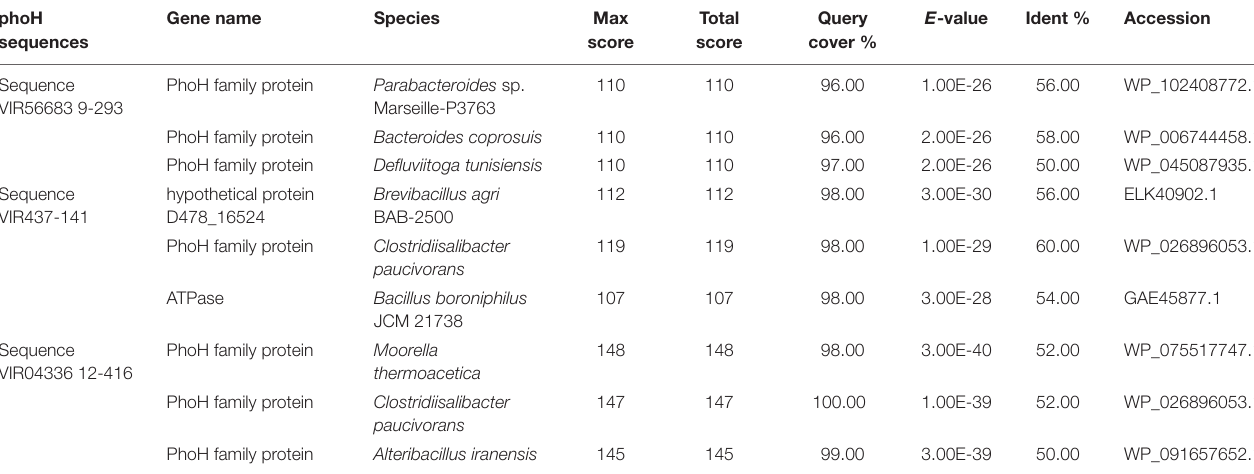
FIGURE 6 | Phylogenetic analysis of viral fractions from Shark Bay stromatolites for phoH (of the pho regulon) in dsDNA viruses. Maximum-likelihood tree of phoH protein sequences obtained from dsDNA viruses. Reference sequences were retrieved from Uniprot database. Alignments were performed using MUSCLE and gaps in alignment were removed with UGENE. The tree was constructed with IQ-TREE v. 1.6.1 with 1000 bootstrap replicates and was visualized with iTOL. Number indicates bootstrap values, nodes with bootstrap values lower than 70 were not shown and represented by the collapsed branch. The collapsed branches in this figure represent reference sequences from Goldsmith et al. (2011) for the phosphate starvation inducible protein (phoH) that have lower than 70 bootstrap values. TABLE 4 | BLAST results against NCBI for phoH sequences in the Shark Bay viral